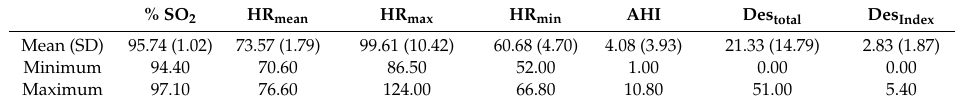
Table 2. Respiratory polygraphy results ( n = 25). Note: % SO 2 , oxygen-saturation percentage; HR mean , mean heart rate; HR max , maximal heart rate; HR min , minimal heart rate; AHI, apnoea–hypopnea index; Des total , total desaturation; Des index , oxygen-desaturation index.